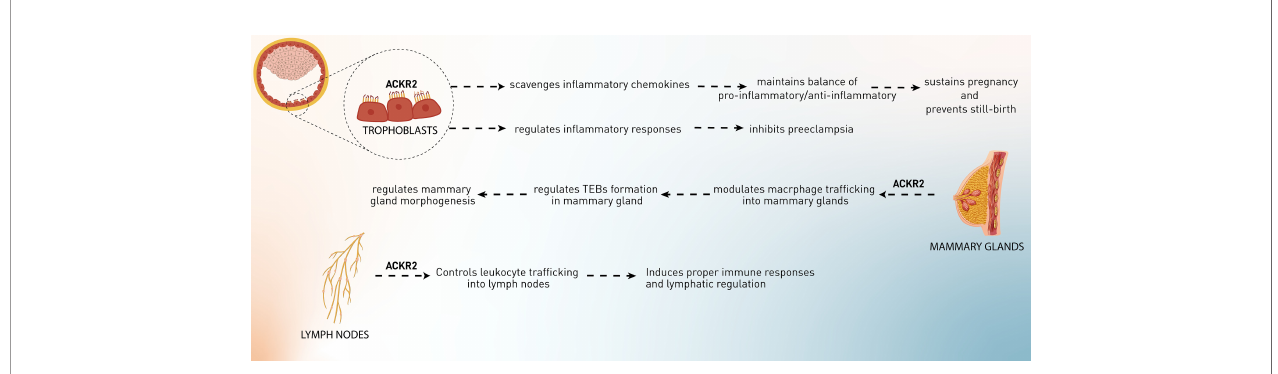
FIGURE 1 | The role of ACKR2 in the physiological processes, including pregnancy, development of mammary glands, and